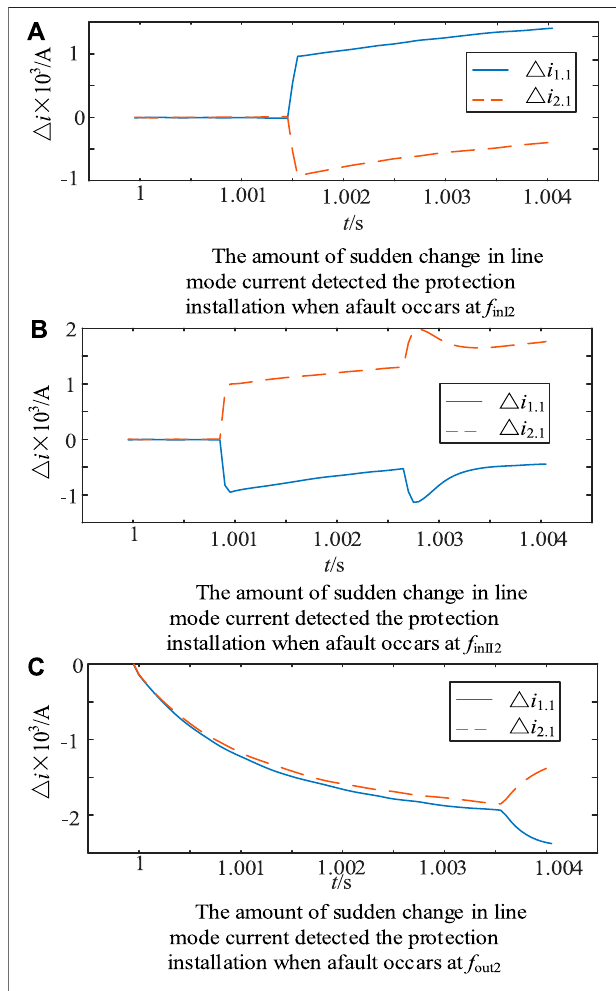
FIGURE 6 | Mode component mutation of the fault current